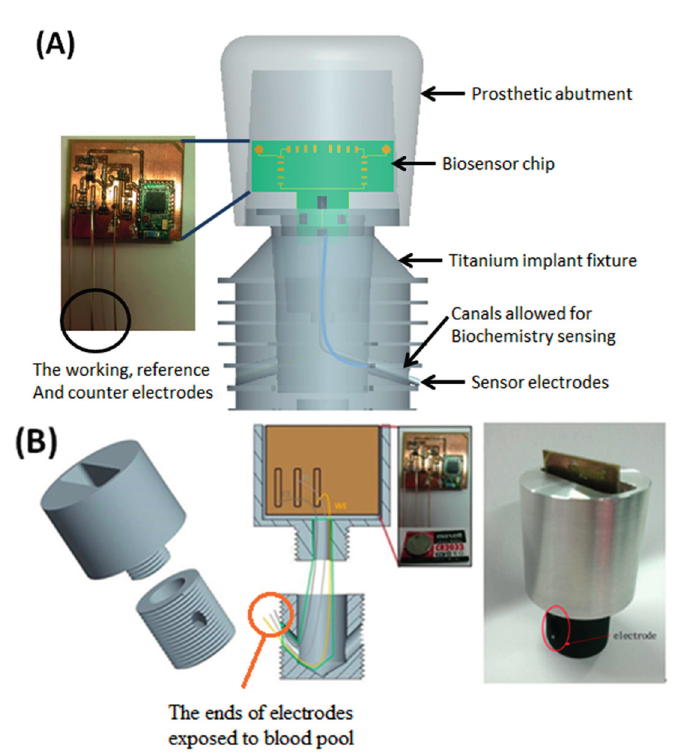
Figure 2. The design of the intra-oral implant-supported biosensor over maxilla. ( A )